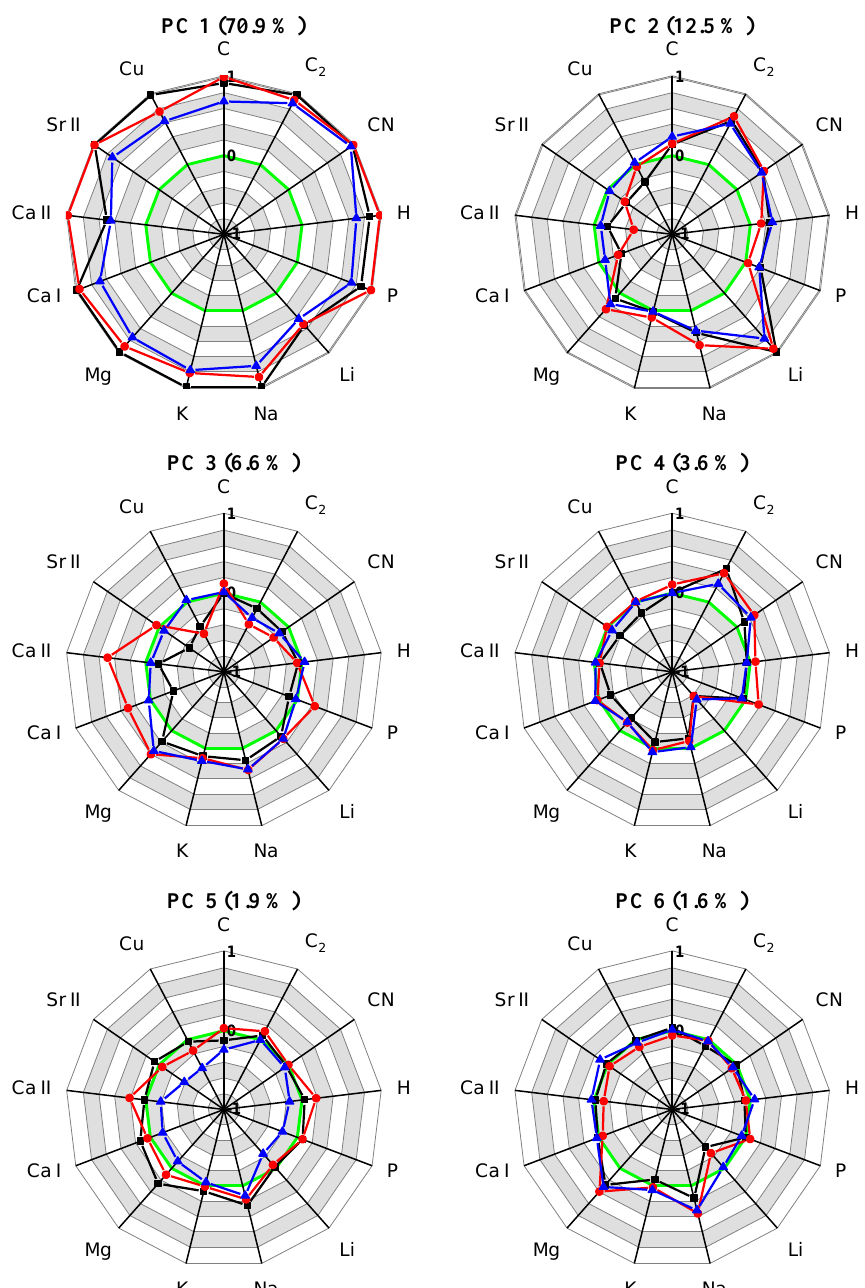
Figure 3. Selected features of PCA loadings for LIBS. Black, red, and blue lines correspond to dark, medium-coloured, and light spots, respectively. The width of the rings is 0.2. The green circle is at the zero level.